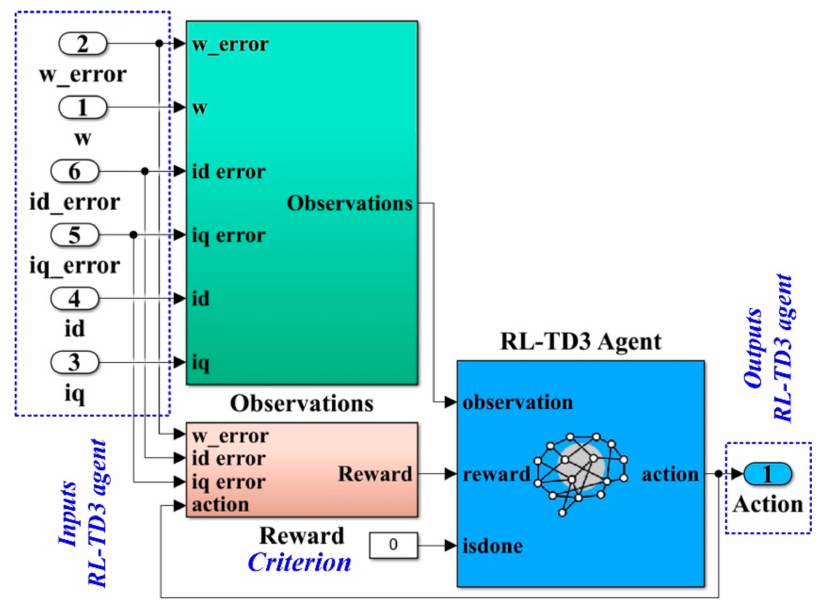
Figure 10. Matlab/Simulink implementation of the RL-TD3 agent for the proposed